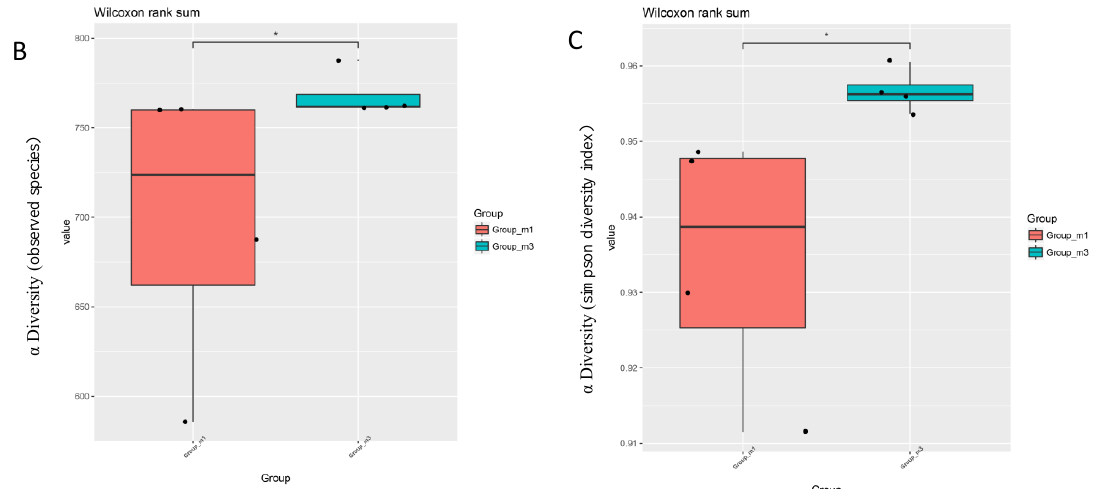
Figure 1. E. faecium -modulated gut microbiota of broilers: ( A ) principal component analysis (PCA) scores indicated the di ff erence in gut microbiota populations and ( B , C ) observed species and Simpson diversity indexes of the gut microbiota. m1, control. m3, E. faecium . ns, not significant. * p <